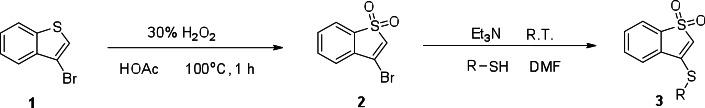
Synthesis of 3-substituted benzo[b]thiophene-1,1-dioxides.